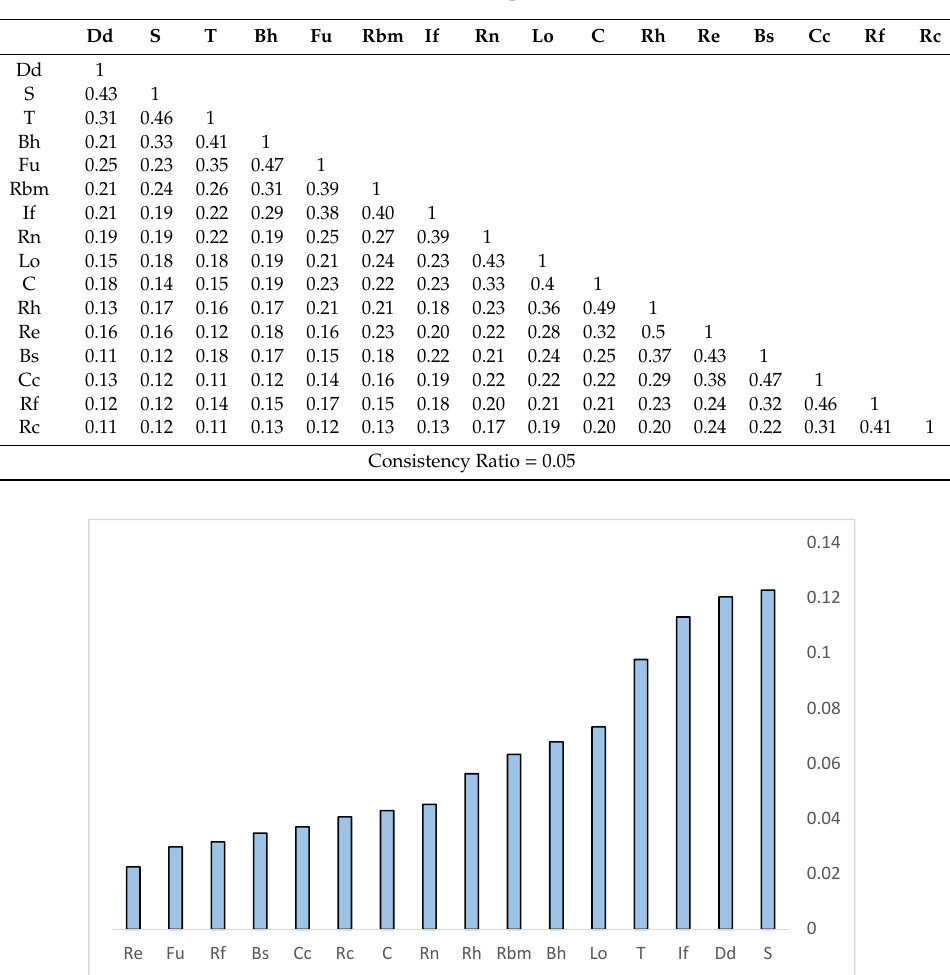
Table 6. Pair-wise comparison matrix.